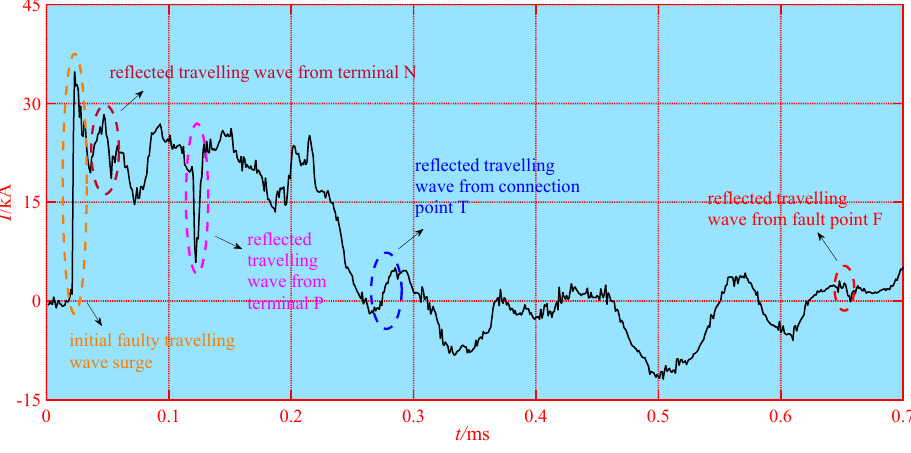
Figure 19. Travelling wave arrive sequence.